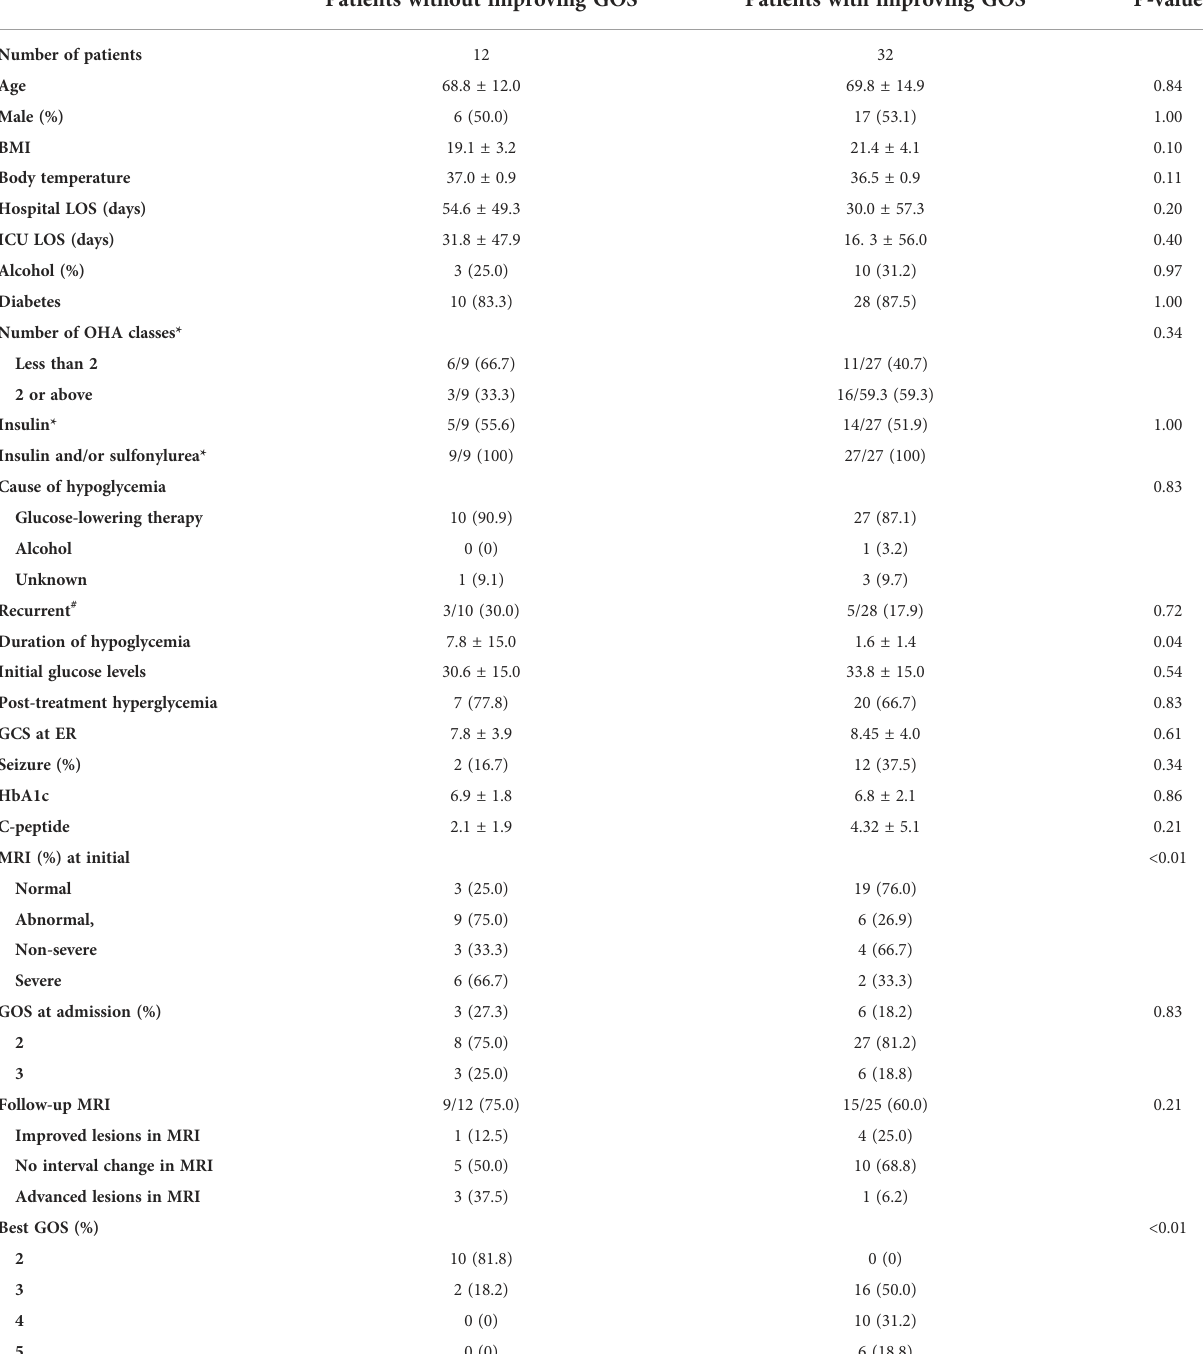
TABLE 1 Baseline characteristics of patients with hypoglycemic encephalopathy. Patients without improving